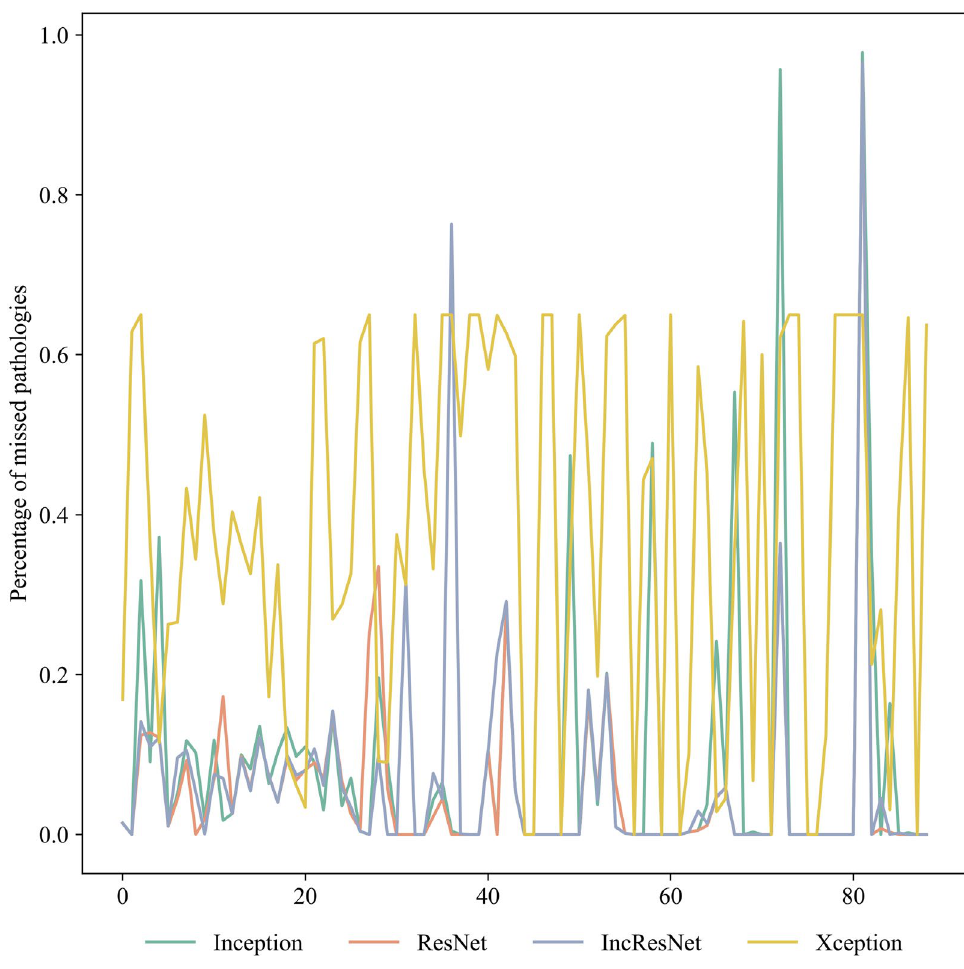
Figure 7. DR pathology missed by different CNNs on the test